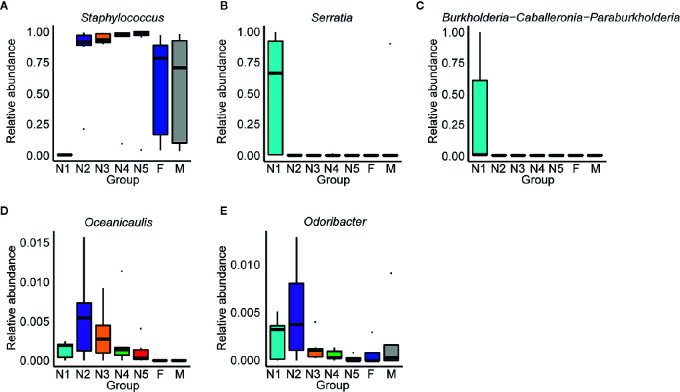
Relative abundances of the significantly altered 15 most important gut genera across developmental stages of T. rubrofasciata. Each column represents one group (N1, 1st stage nymphs; N2, 2nd stage nymphs; N3, 3rd stage nymphs; N4, 4th stage nymphs; N5, 5th stage nymphs; F, female adult; M, male adult). The top and bottom whiskers indicate the maximum and minimum values, respectively, and the hyphen represents the median value. (A)
Staphylococcus. (B)
Serratia. (C)
Burkholderia-Caballeronia-Paraburkholderia. (D)
Oceanicaulis. (E)
Odoribacter.